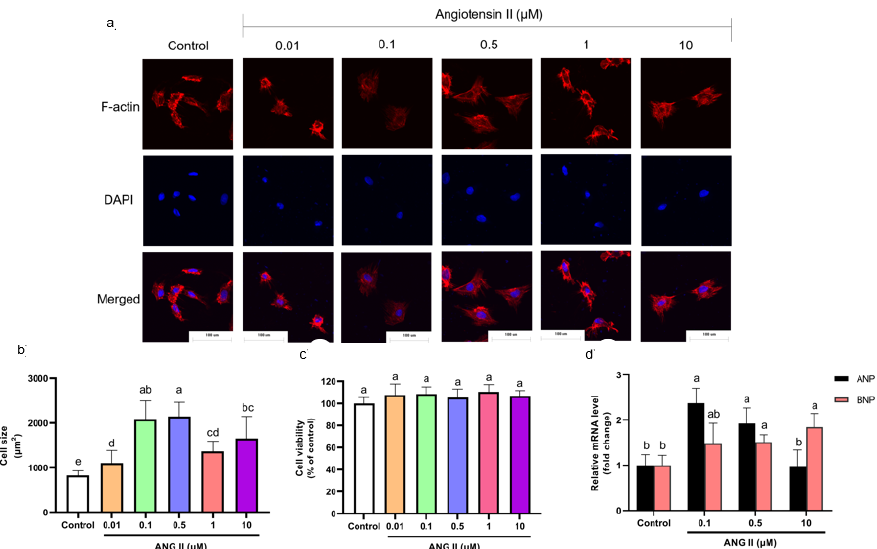
Figure 1. ( a ) Morphology change of H9c2 cells treated with different concentrations of ANGII ( × 400). ( b ) Size of H9c2 cells treated with ANGII. ( c ) Viability of H9c2 cells treated with ANGII. ( d ) ANP and BNP mRNA level of H9c2 cells treated with ANGII. Significant differences between different treatments were shown by different letters ( p <